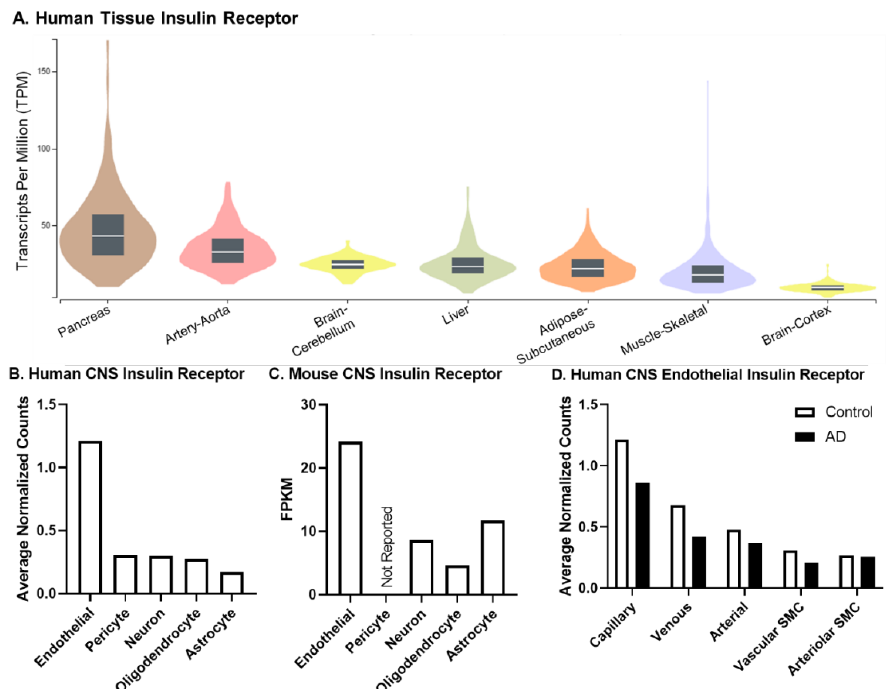
Figure 2. Expression (mRNA) of the insulin receptor (IR). Existing online, publicly available data resources were used to generate each sub-figure. ( A ) Expression of IR mRNA in human tissues was organized from the GTEx portal. Box plots are shown as the median, and 25th and 75th percentiles. The sample size range is 226–803. Outliers are not shown. The transcript data is based on the GTEx Analysis Release V8. ( B ) Human CNS IR data were extracted from the Human BBB Project [47] where the endothelial values shown are from capillary expression, pericytes are from solute transport pericytes, and astrocytes are from the cortex. Tissue samples were taken from post-mortem superior frontal cortex ( n = 4) and hippocampus ( n = 8–9) and pooled unless otherwise stated. ( C ) Mouse CNS IR data were extracted from the Brain RNA-Seq data base [48]. Briefly, two biological replicates were used to generate the database (one biological replicate consists of cells purified from 3–12 mouse cerebral cortices) and cell types were purified from different mice. Pericyte data were not shown due to the small contamination of astrocytes and endothelial cells. ( D ) Human CNS Endothelial IR data were also extracted from the Human BBB project [47]. Only the vascular cell types are shown and levels are compared between controls and AD samples. AD classification was based on a clinical diagnosis. All data were accessed on 4 April 2022.